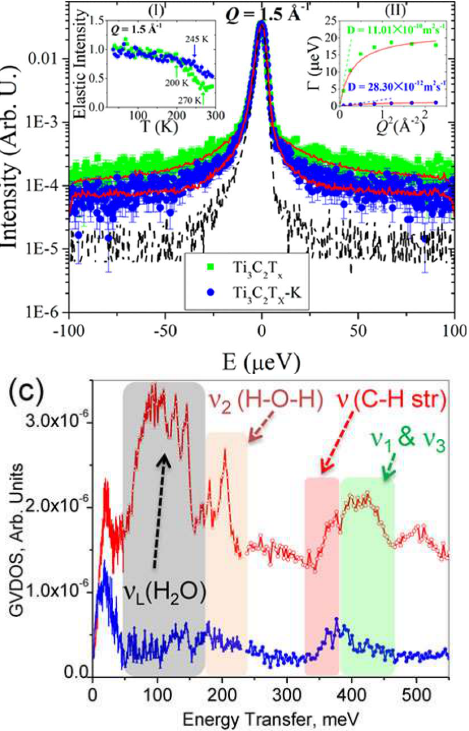
Fig. 11 . Top: QENS spectra of MXenes samples measured at BASIS. Reprinted with permission from [77]. Copyright 2016 American Chemical Society. Bottom: the generalized vibrational density of states of MXene samples before (red curve) and after (blue curve) annealing, from the INS spectra measured at SEQUOIA. Reprinted with permission from [78]. Copyright 2014 American Chemical